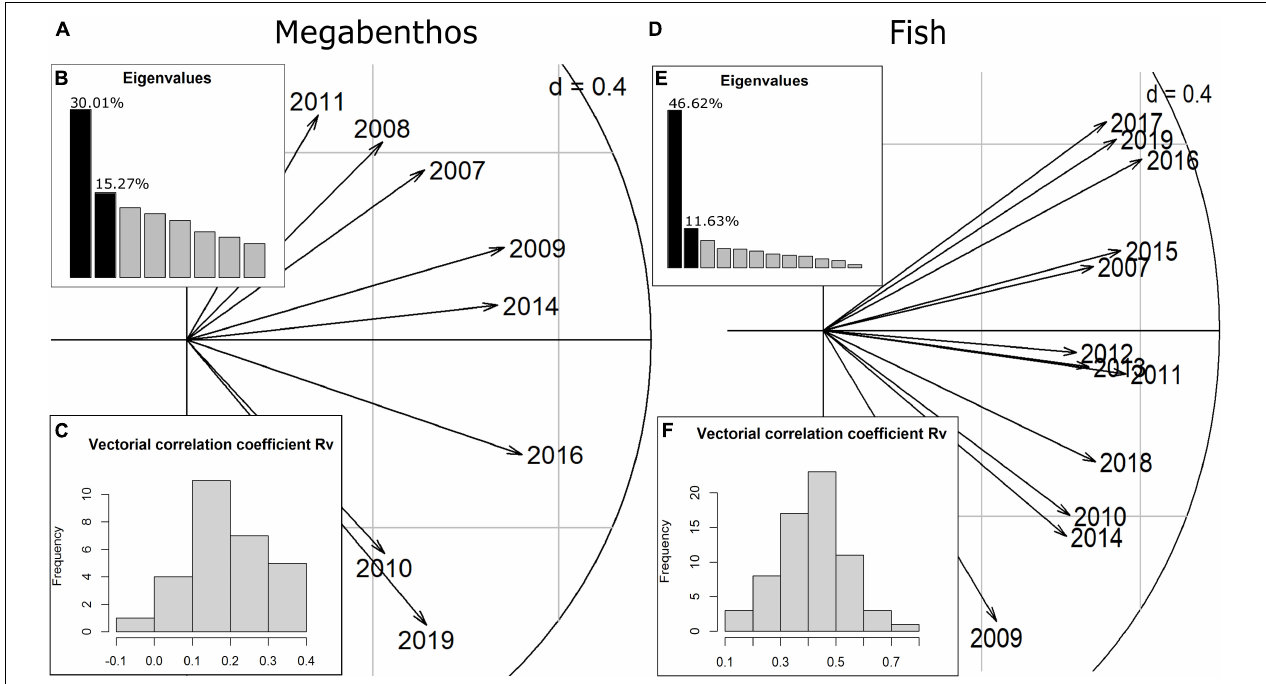
FIGURE 3 | Interstructure analysis with correlation circle with scores for years for megabenthos (A) and fish (D) . (B,E) Eigenvalues of the Rv matrix that gathers vectorial correlation in taxa-environment covariances between 2 years). (C,F) Histogram of the Rv values between 2 years.